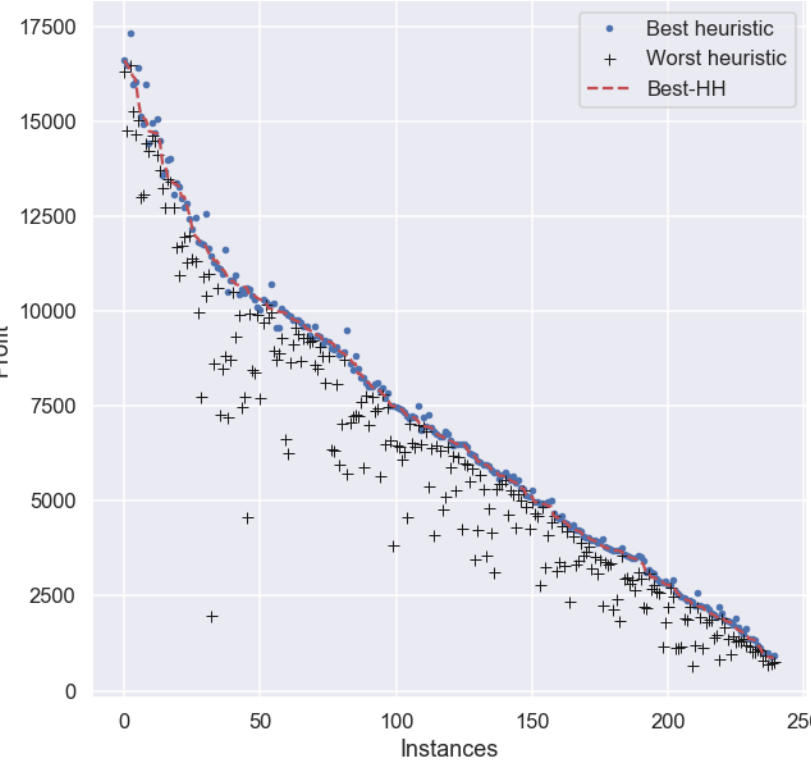
Figure 5. Profit per instance obtained by the best hyper-heuristic trained on 60% of set β 1 , and the best and worst heuristic per instance on the remaining 40% of set β 1 .